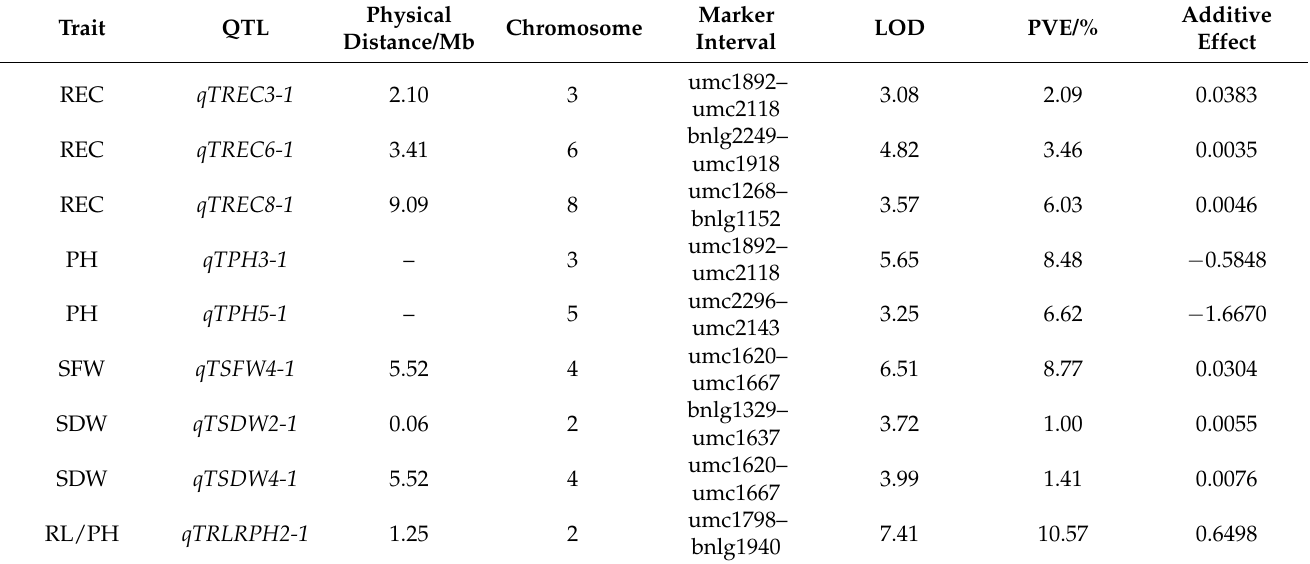
Table 2. Summary of main QTLs controlling seedling traits of F 2:3 population (2 ◦ C; 5